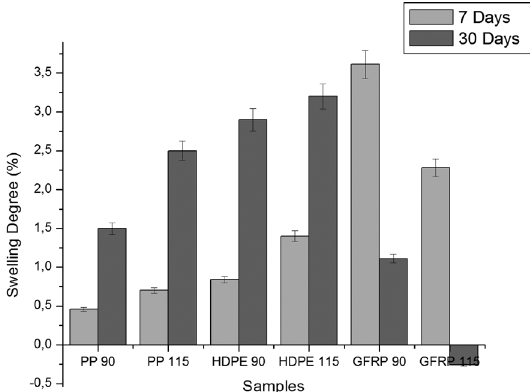
Figure 3. Variation of the materials swelling degree in different moments of the testing.